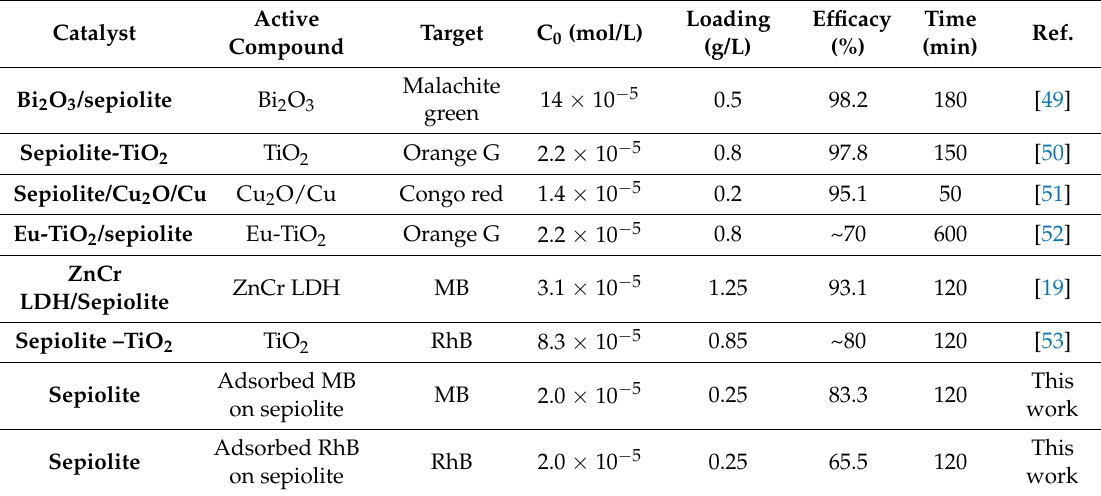
Figure 7. Time-dependent changes in HPLC spectra of RhB and degradation products on sepiolite under the visible light irradiation. Table 2. Comparison of photocatalytic efficiency of sepiolite composites with other reported photocatalysts for organic dye